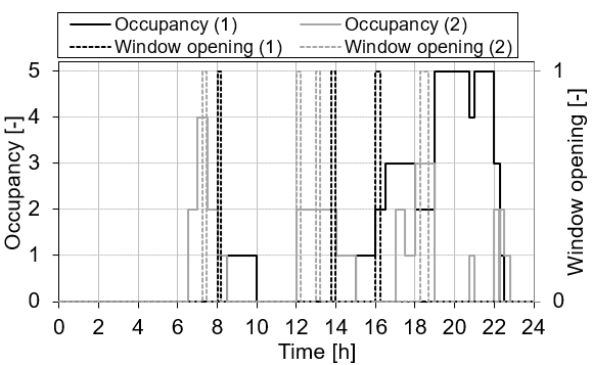
Figure 6. Occupancy and ventilation profile of the living room (1) and the kitchen/bath (2).